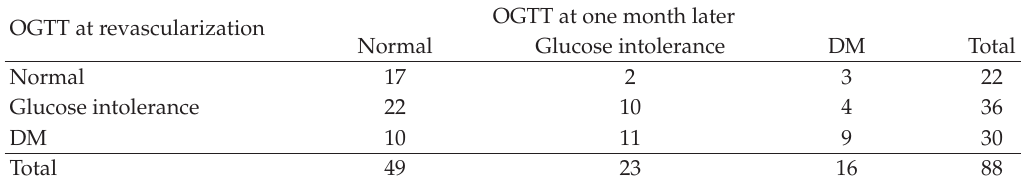
Table 4: Data for example 2.